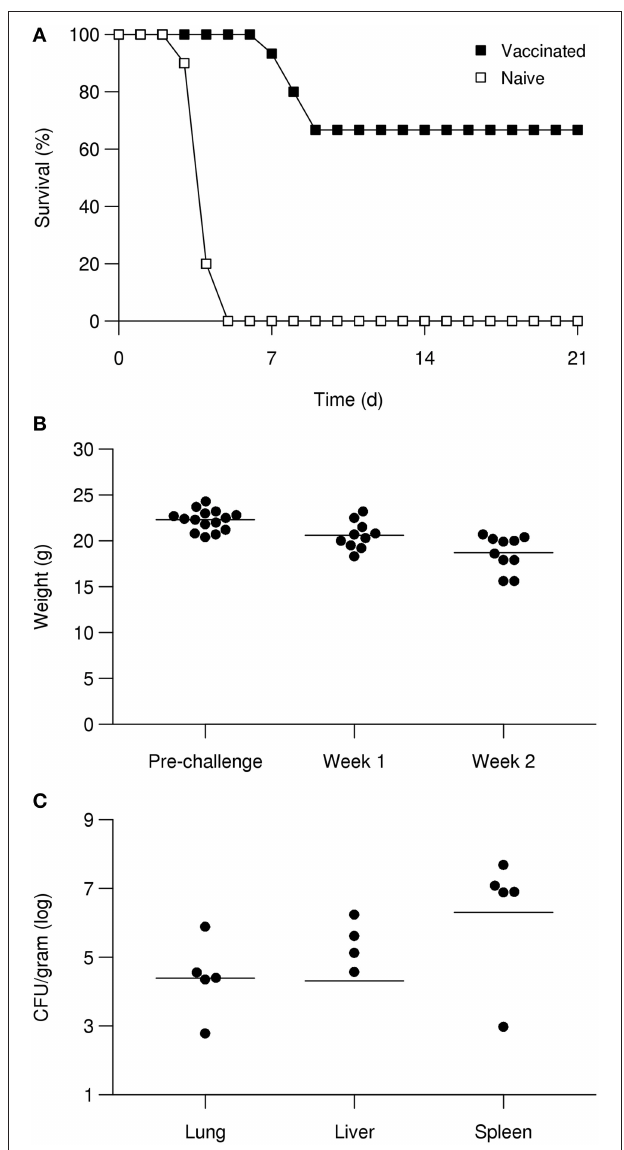
FIGURE 7 | 1 TssN vaccine efficacy against aerosol challenge with high-dose ATCC 23344 in BALB/c mice. Mice were vaccinated with 1 TssN via aerosol delivery on day 0 and 21 and challenged along with naïve mice via aerosol exposure on day 42. Survival curves of naïve and vaccinated mice after aerosol challenge with 43 LD 50 of Bm ATCC 23344 over 21 days (A) . Body weights of vaccinated surviving mice at prechallenge, 2 week postchallenge, and 3 week postchallenge (B) . Recovered CFUs from five of the vaccinated surviving mice at 21 days postchallenge from the lung, liver, and spleen (C) .